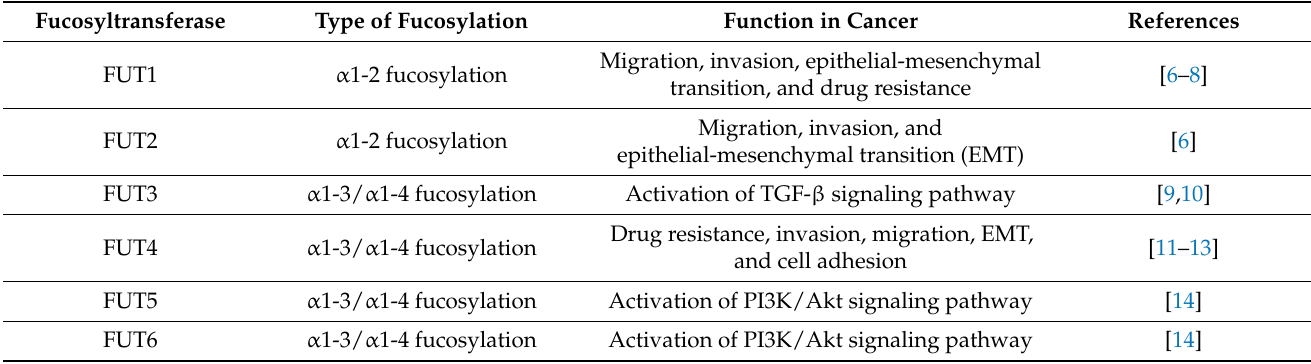
Table 1. Biological function of